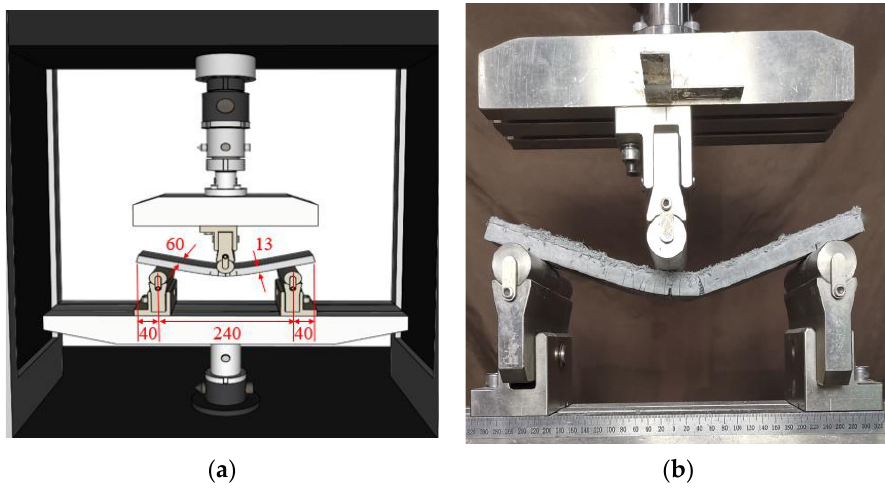
Figure 2. ( a ) Geometry and ( b ) test setup of three-point bending test specimens (unit: